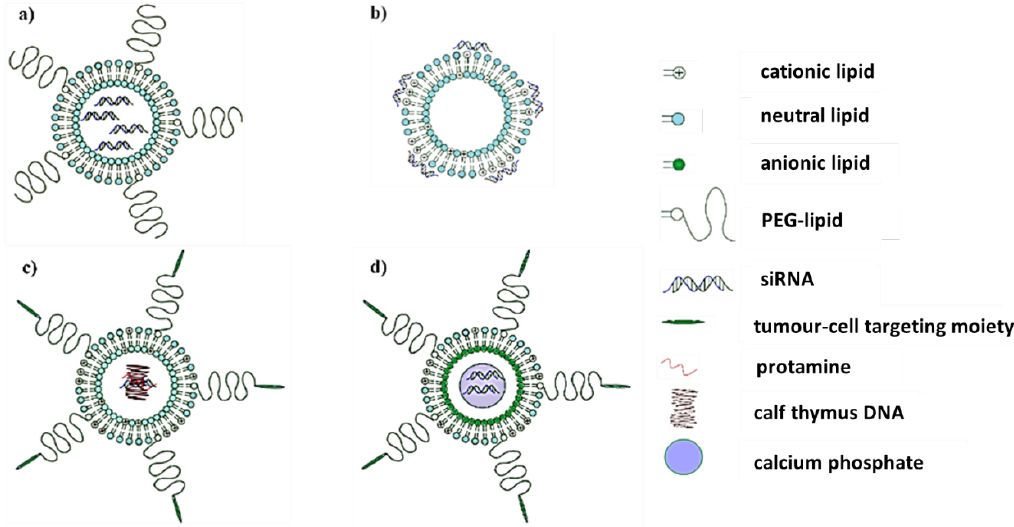
Figure 2. Lipid-based delivery agents for anti- c-myc siRNA ( a ) pegylated, neutral liposome, ( b ) cationic liposome, ( c ) liposome-polycation-DNA (LPD) nanoparticle, and ( d ) lipid calcium phosphate (LCP) nanoparticle. Images were created using DesignSpark Mechanical 2.0 software.